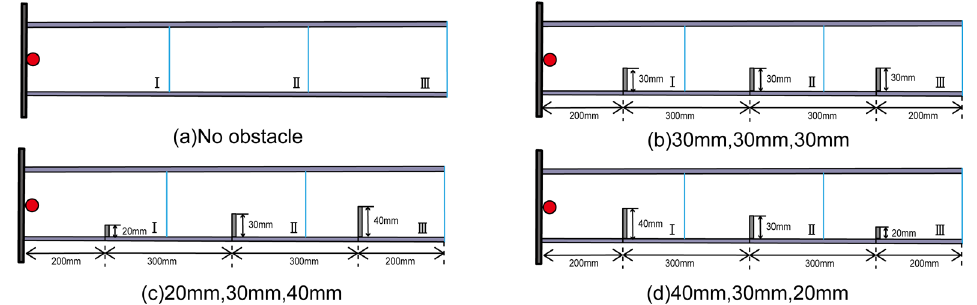
Figure 6. Simulated working conditions.